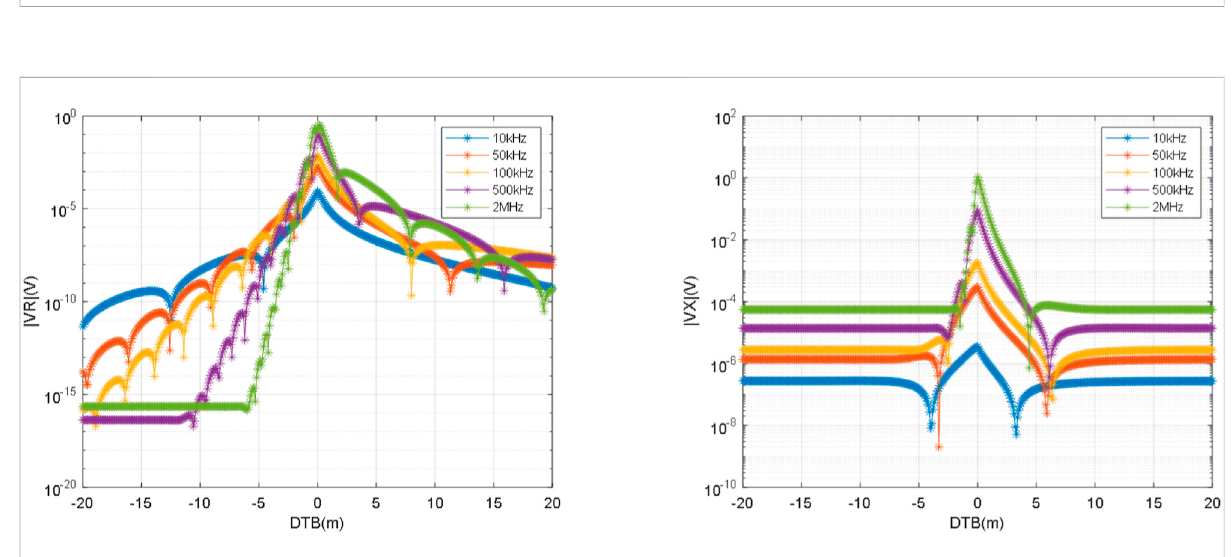
FIGURE 9 Response of the orthogonal receiver at different